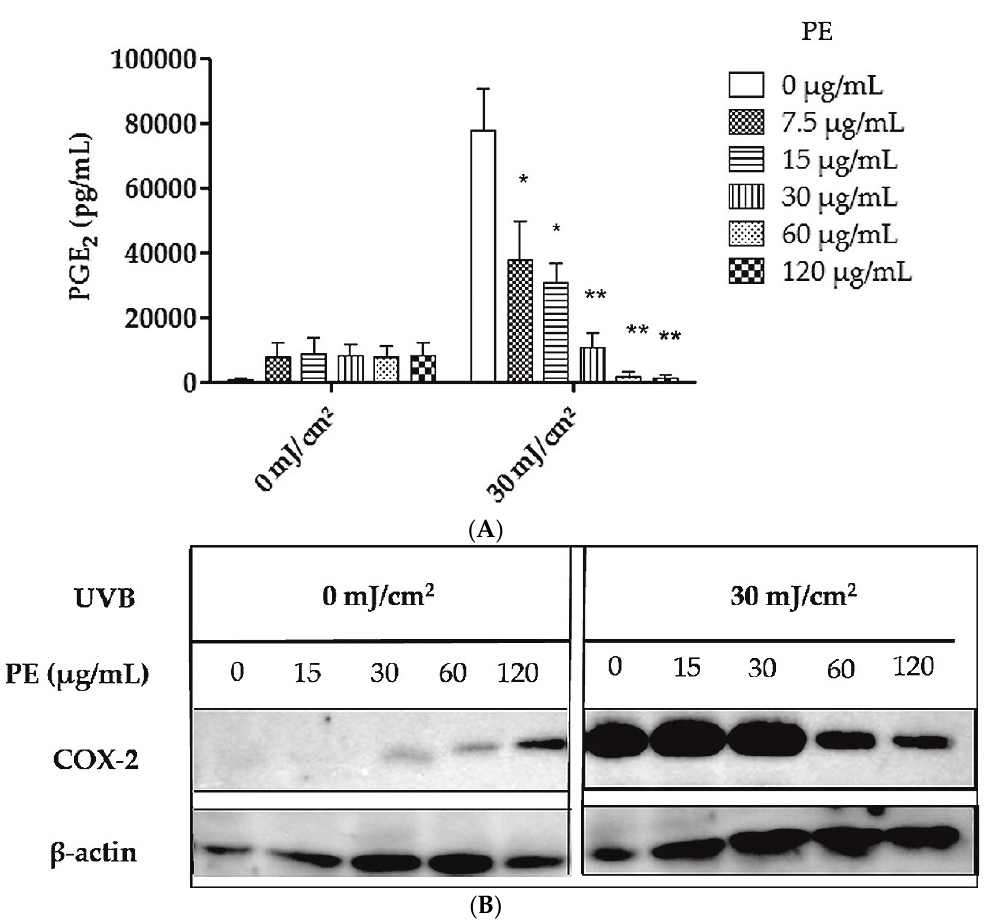
Figure 2. Effect of unfractionated PE extract on UVB-induced COX-2 expression and PGE 2 production in HaCaT keratinocytes. HaCaT cells were sham irradiated or irradiated with 30 mJ/cm 2 UVB. ( A ) After irradiation the cells were treated with PE extract for 24 h before the PGE 2 concentration was measured in the cell culture supernatants. Data are expressed as mean ± SD of three independent experiments and the statistical significance was determined compared to the irradiated, untreated control (* p < 0.05; ** p < 0.01); ( B ) After irradiation the cells were treated with PE extract for 24 h. Then the cells were lysed and analyzed for COX-2 expression by western blotting. β -actin served as loading control.